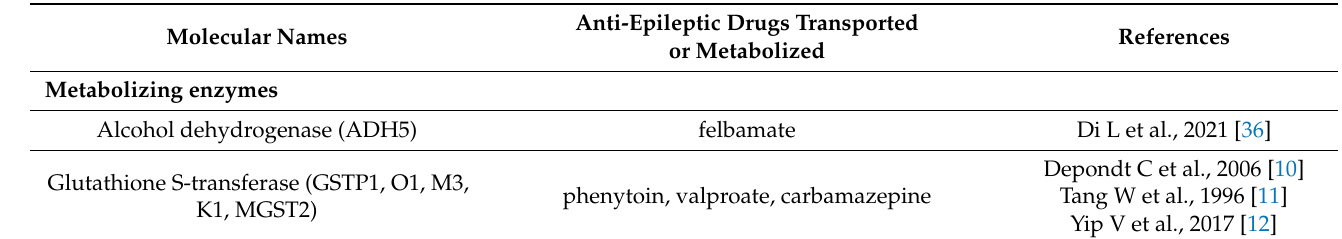
The AED transporters and metabolizing enzymes detected by SWATH analysis are listed in this table. The substrates (AEDs) of the corresponding transporters and metabolizing enzymes are listed on the basis of literature search.